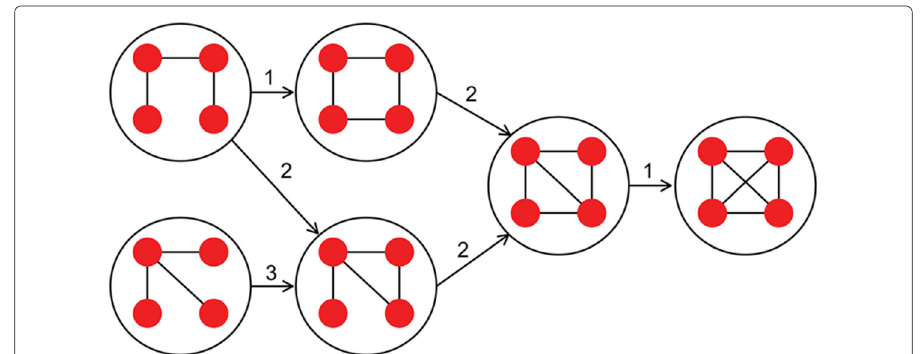
Fig. 6 Compressed AS containing all the possible 4-nodes non-isomorphic subgraphs. Edges are weighted by the number of occurrences of a subgraph that can be obtained from another subgraph by adding one edge in all possible ways